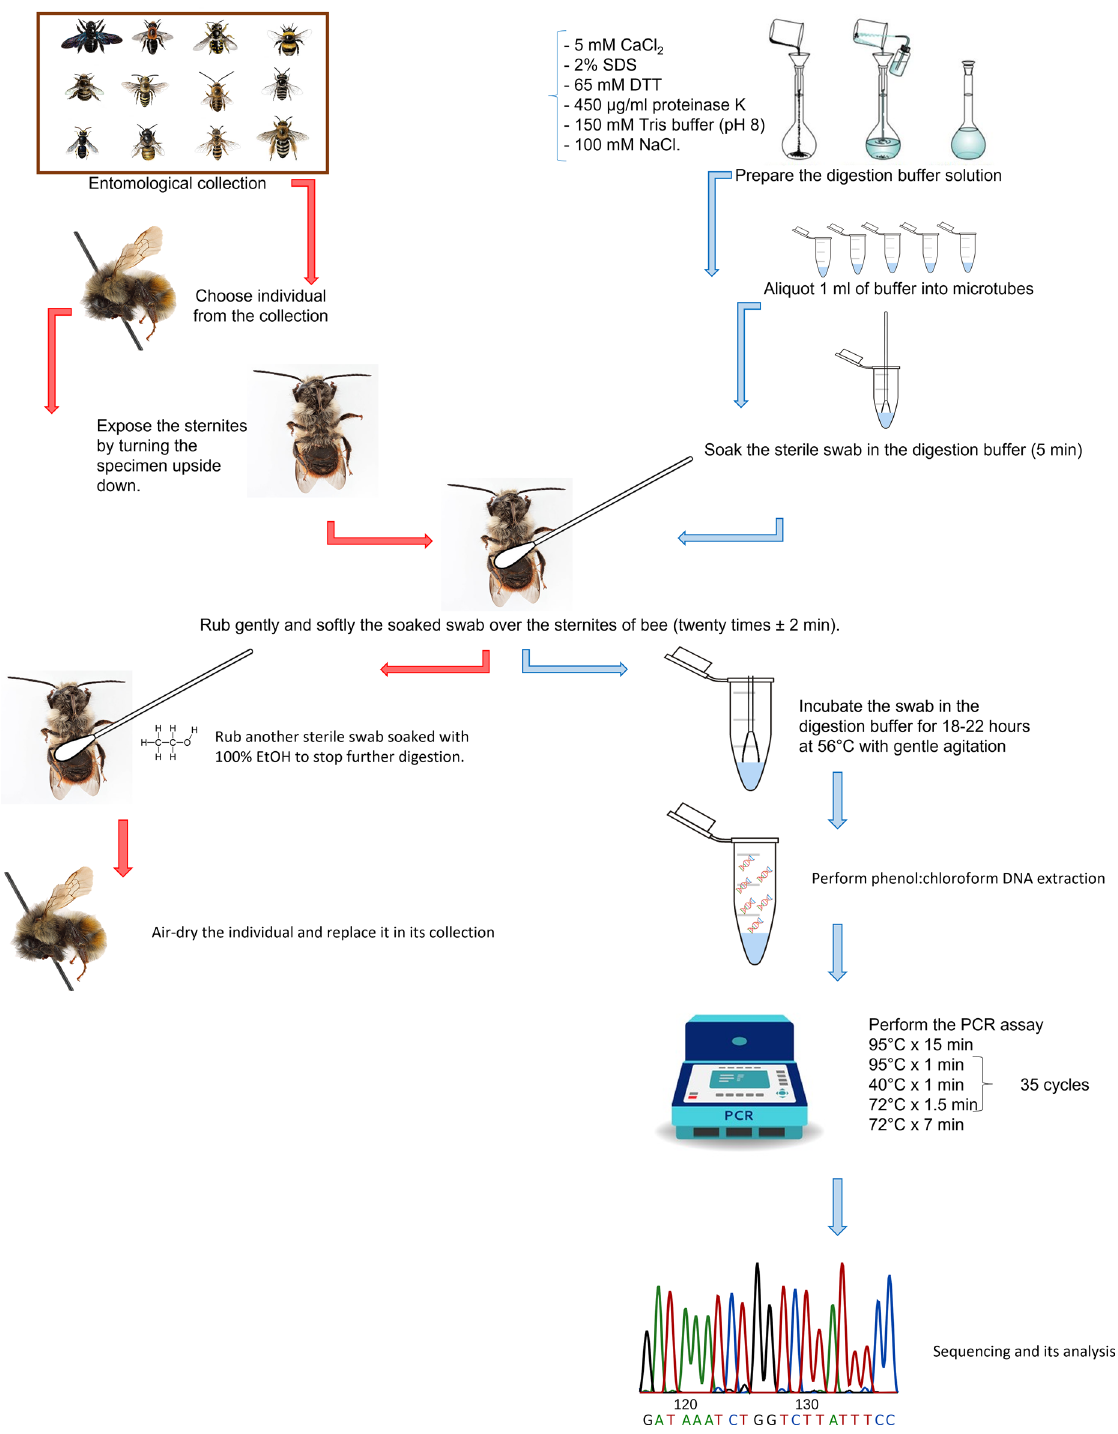
Figure 4. Schematic description of the experimental